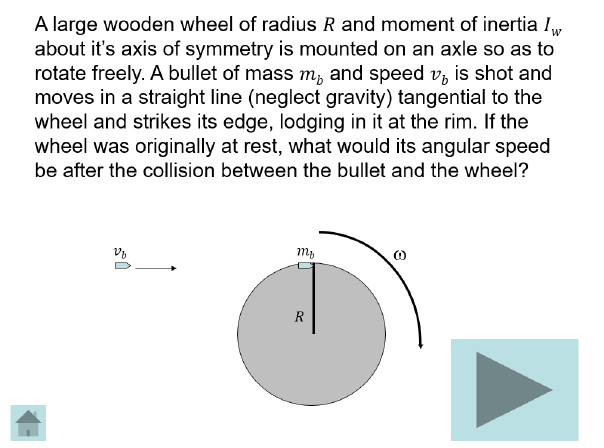
FIG. 1. The overarching problem in the conservation of angular momentum